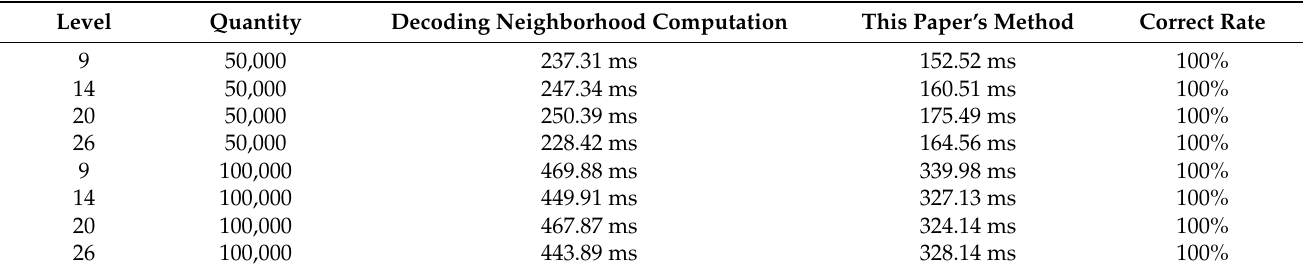
Table 6. Time calculation experiment results table.